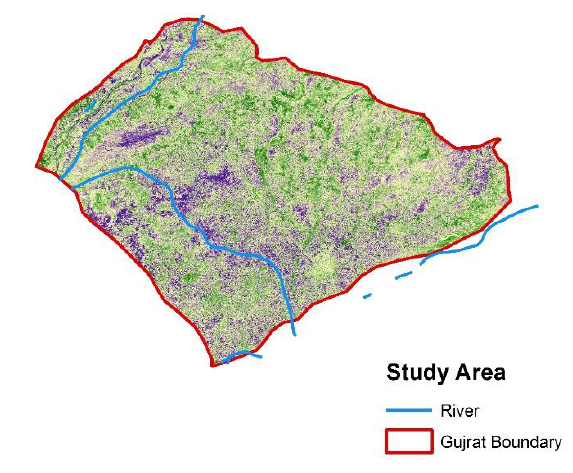
Figure 1. Study Area which represent boundary and river of